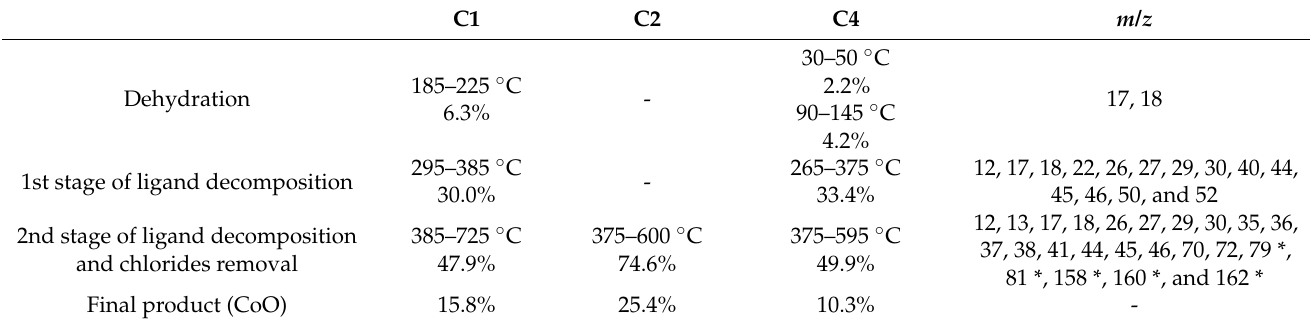
Table 2. Temperature ranges, mass losses, and m/z signals of thermal-decomposition stages of studied